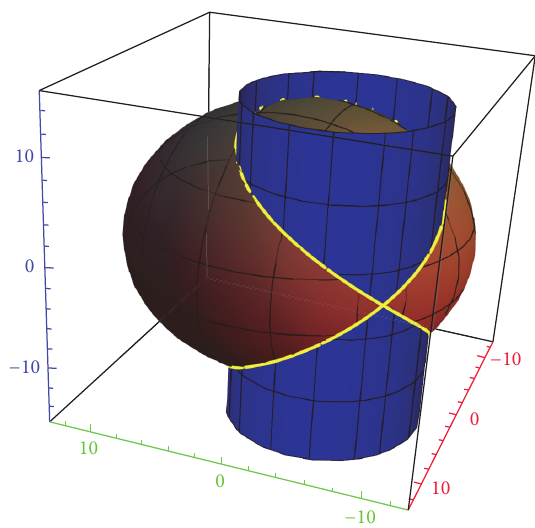
Figure 6: The fiber F (ℎ,𝑐) , (ℎ,𝑐) ∈ Σ 𝑢 2 : a pair of homoclinic